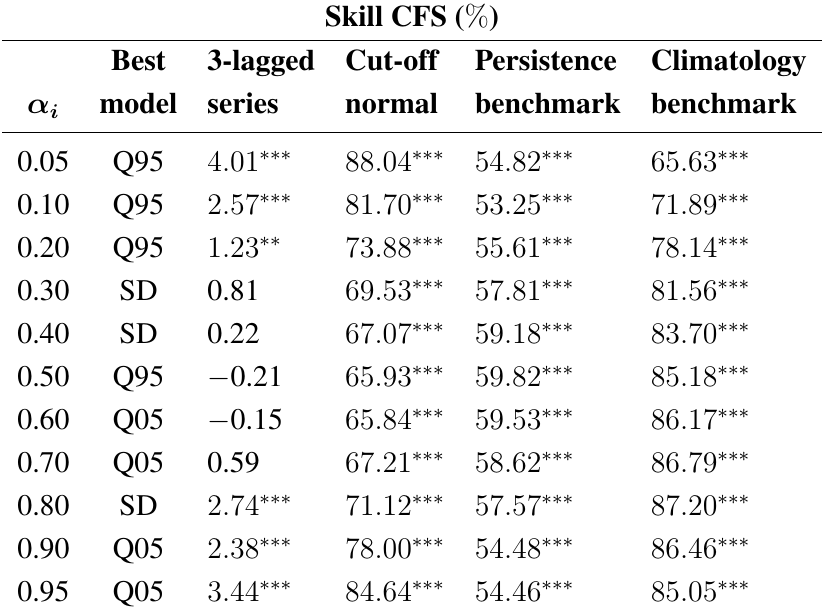
gain/loss with respect to the four reference (benchmark) models, for each quantile.